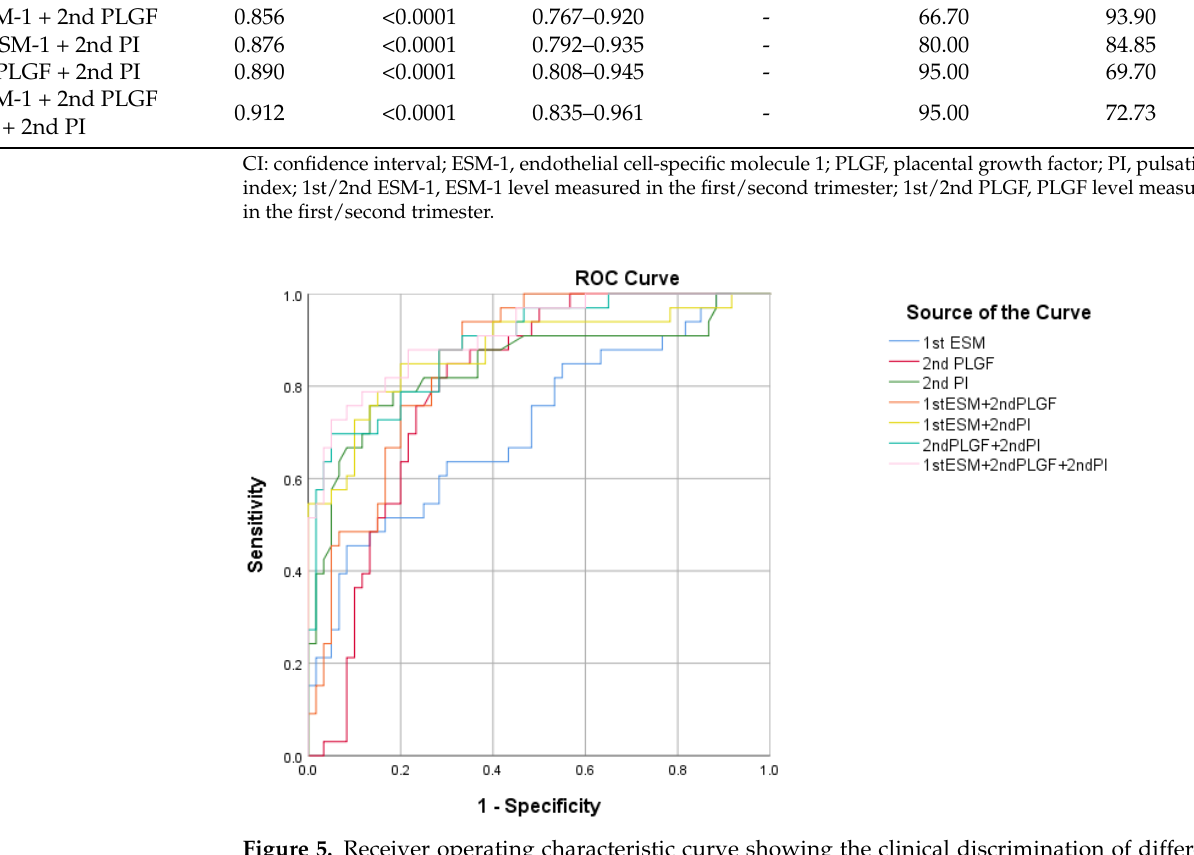
Figure 5. Receiver operating characteristic curve showing the clinical discrimination of different markers alone or in combination in the detection of severe preeclampsia. Table 3. Predictive efficiency of biomarker levels and PI for severe preeclampsia.